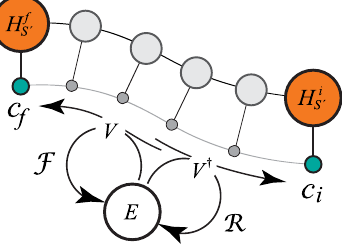
FIG. 2. An intermediate quantum Crooks relation. Our quan- tum Crooks theorem is based on the idealized concept of a perfect control mechanism. This assumes that the energy-conserving unitary evolution V on the joint system S 0 CE turns the control state j c into j c with certainty, thus implementing the change of i i f i the Hamiltonian H i to H f perfectly. To model the forward S 0 S 0 process of the Crooks relation, we assume that S 0 C starts in the “ conditional ” equilibrium state G ð H i Þ ⊗ j c i ih c i j . The sub- S 0 sequent evolution under V induces a channel F on the energy reservoir E . As an intermediate step towards the quantum Crooks relation (2), we assume that the reverse process is given by the globally reversed evolution V † . With S 0 C in the initial state G ð H f Þ ⊗ j c f ih c f j , this results in a channel R on E . The S 0